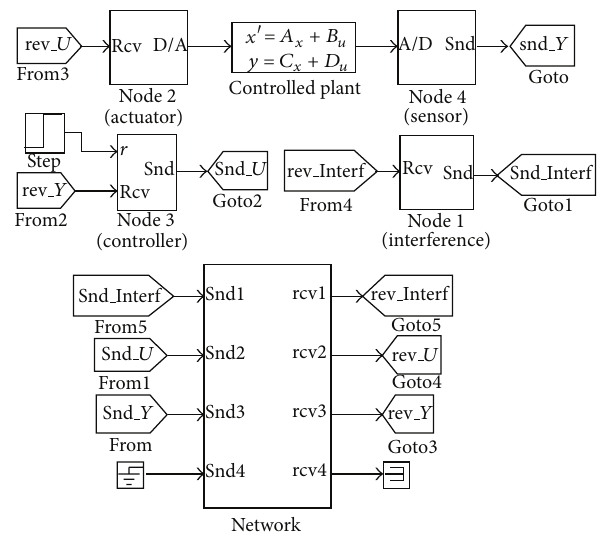
Figure 6: The simulation diagram of the NCS based on single-level 100 M switched Ethernet.